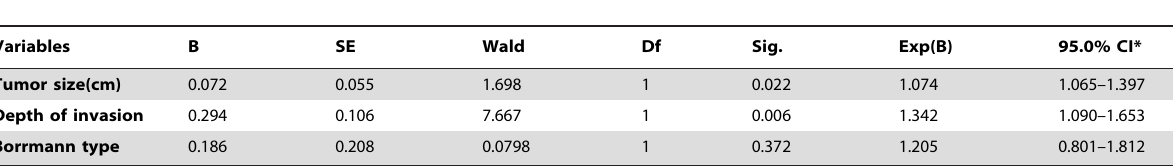
Table 2. Prognostic factors retained at multivariate analysis by Cox